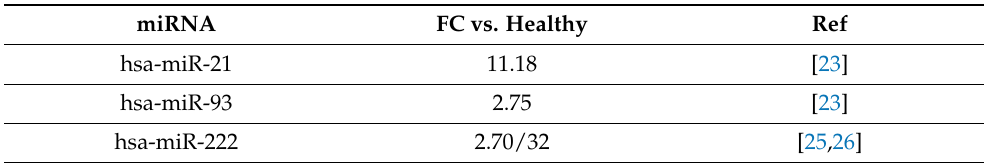
Table 1. miRNAs expression represented as Fold Change (FC) expression in PDAC tumors compared to a healthy